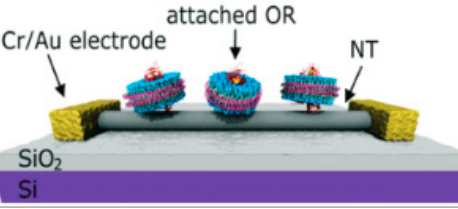
Figure 20. Transistor for the detection of odors (“e-nose”). From Reference [112] with permission of the American Chemical Society.